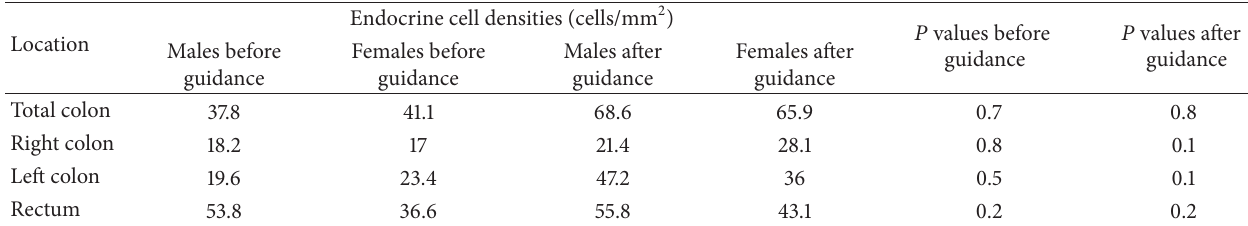
Figure 1: CgA cell densities in the total colon (a), right colon (b), and left colon (c) of IBS patients before and after receiving dietary guidance. The dashed lines labeled “a” and “c” indicate the upper and lower limits of the 95% confidence interval for control subjects, respectively, while line “b” indicates the mean CgA cell density. ∗ 𝑃 < 0.05 . ∗∗ 𝑃 < 0.001 . ∗∗∗ 𝑃 < 0.0001 . Table 1: Densities of chromogranin A cells in the total colon, right colon, left colon, and rectum of the patients, defined by their gender, before and after receiving dietary